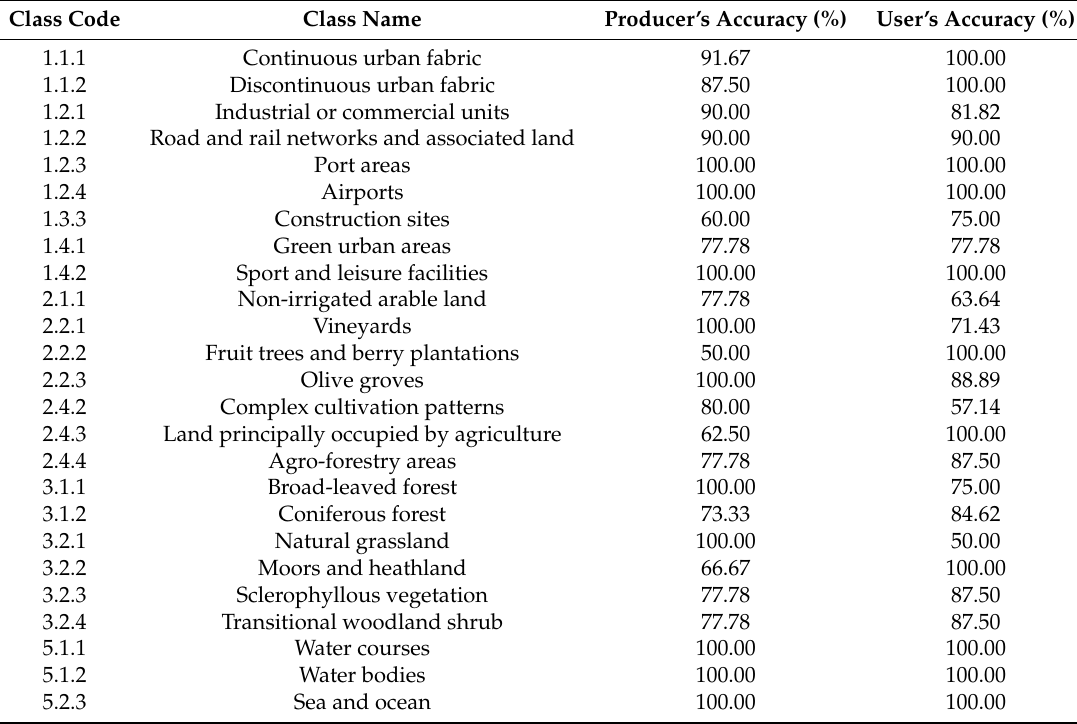
Table 6. Accuracy assessment results of Level 3 classes.